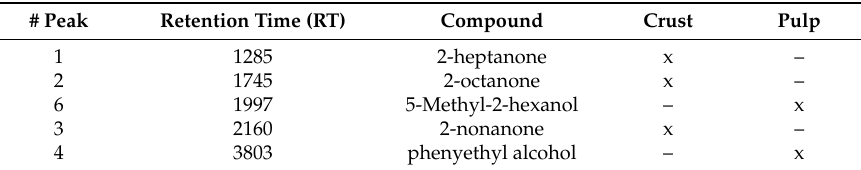
Table 1. List of the selected chemicals compounds.